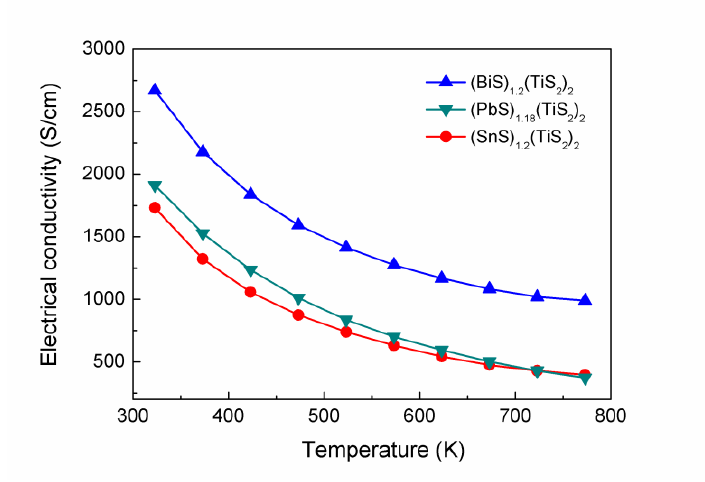
Figure 3. Electrical conductivities of (BiS) 1.2 (TiS 2 ) 2 , (SnS) 1.2 (TiS 2 ) 2 and (PbS) 1.18 (TiS 2 ) 2